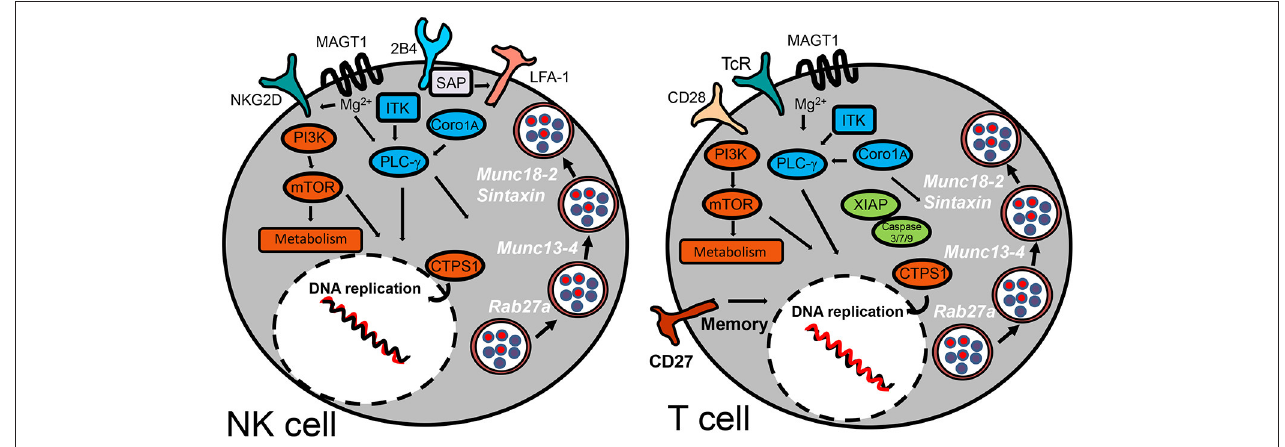
FIGURE 3 | Inborn errors predisposing to EBV-morbidity by compromising NK and T cell cytotoxic activity . The schematic diagram highlights the cell surface receptors and signaling-pathway elements that are responsible to control infection for herpesviruses. Signaling proteins shown in blue are those involved in regulation of PLC- γ . Those shown in orange are implicated in regulation of metabolism. XIAP is the only signaling protein described hitherto implicated in regulation of apoptosis. SAP has been shown to influence cell-mediated cytotoxicity by promoting NK cell adhesion by an LFA-1-dependent mechanism. Cytosolic proteins regulating vesicular traffic of cytotoxic granules are indicated in white.